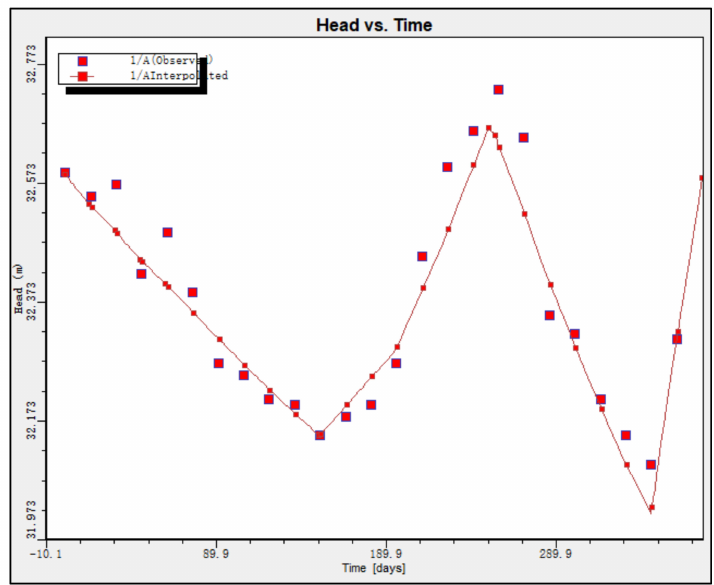
Figure 6. Diagram showing the water level fit for the Zhangying 50671120 monitoring well in Linquan